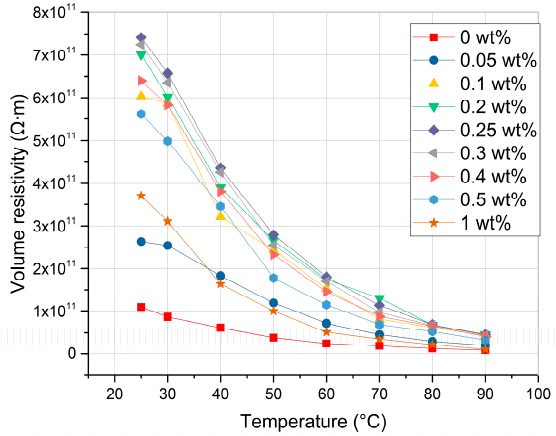
Figure 9. Temperature dependence of the volume resistivity of nanofluids with ST TiO 2.